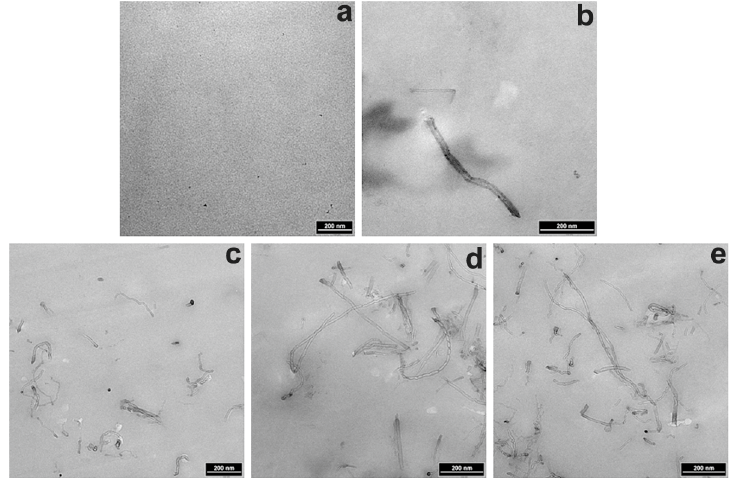
Figure 4. Transmission electron microscope (TEM) images of the nanocomposite bioplastics: ( a – e ) 0.0, 0.1, 0.5, 1.0, and 2.0 wt %, respectively. TEM images of the BioPU nanocomposites 0.0, 0.1, 0.5, 1.0, and 2.0 wt % are shown in Figure 4.